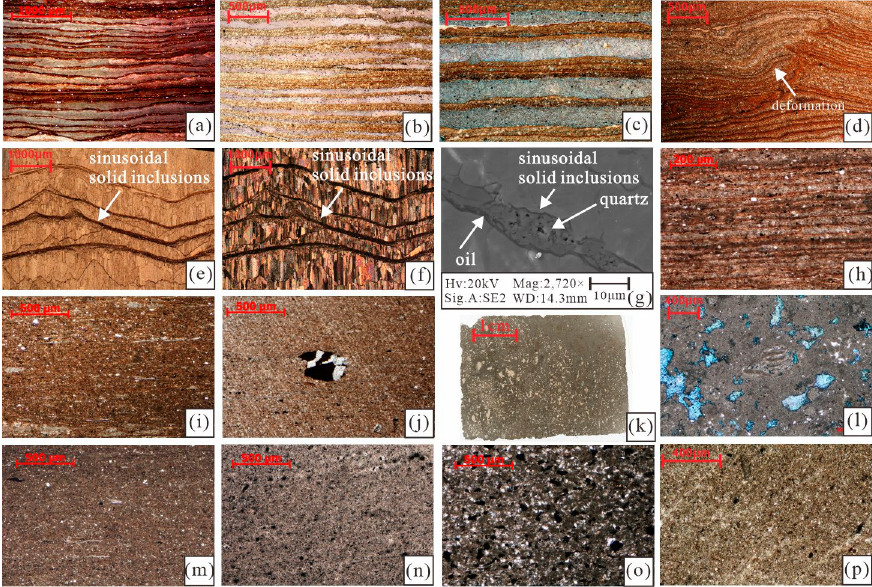
Figure 4. ( a ) The thin section of middle-high organic laminated calcareous fine-grained sedimentary rocks. Dyed calcites are red. Well NY1, 3409.77 m. ( b ) The thin section of middle-high organic laminated calcareous fine-grained sedimentary rocks. Dyed ferrocalcites are mauve. Well NX55, 3789.50 m. ( c ) The thin section of middle-high organic laminated calcareous fine-grained sedimentary rocks. Dyed ankerites are blue. Well NX55, 3784.80 m. ( d ) Laminae are curved due to deformation. Well NY1, 3341.75 m. ( e ) Sinusoidal solid inclusions that are composed of quartz, feldspar, clay minerals. The organic matter develops in the sparry ankerite veins. Well N55X1, 3588.60 m. ( f ) The photo of ( e ) under the crossed-polarized light. Gypsum occurs in the sparry ankerite lamina. Well N55X1, 3588.60 m. ( g ) Quartz, feldspar, clay minerals and organic matter in sinusoidal solid inclusions. Well N55X1, 3588.60 m. ( h ) The thin section of middle-high organic laminated mixed fine-grained sedimentary rocks. Well NY1, 3442.33 m. ( i ) The thin section of middle-high organic flaggy mixed fine-grained sedimentary rocks, Well NY1, 3339.18 m. ( j ) The thin section of middle-high organic flaggy calcareous fine-grained sedimentary rocks, Well NY1, 3360.07 m. ( k ) The scanning photo of the thin section, Well FY1, 3430.8 m. ( l ) The thin section of middle-high organic massive calcareous fine-grained sedimentary rocks. The dyed ankerite is blue. Well FY1, 3430.8 m. ( m ) The thin section of middle organic massive mixed fine-grained sedimentary rocks, Well NY1, 3362.63 m. ( n ) The thin section of low organic massive argillaceous fine-grained sedimentary rocks, Well NY1, 3471.68 m. ( o ) The thin section of low organic massive felsic fine-grained sedimentary rocks. Well NY1, 3468.65 m. ( p ) The thin section of low organic massive mixed fine-grained sedimentary rocks. Well NX55, 3789.73 m.